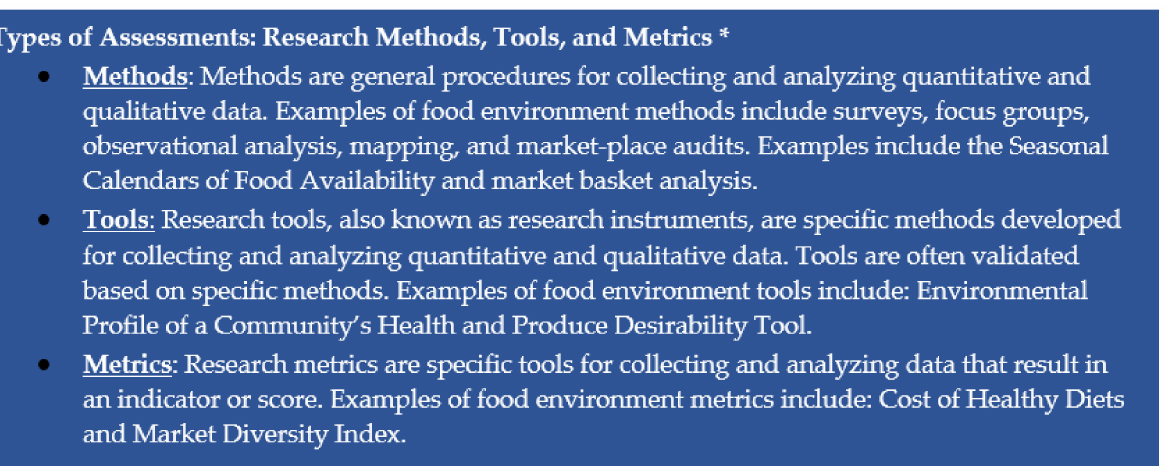
Figure 1. Definitions of assessment types: Methods, tools, and metrics. * This classification system is not always distinct with specific measures falling neatly between tools and